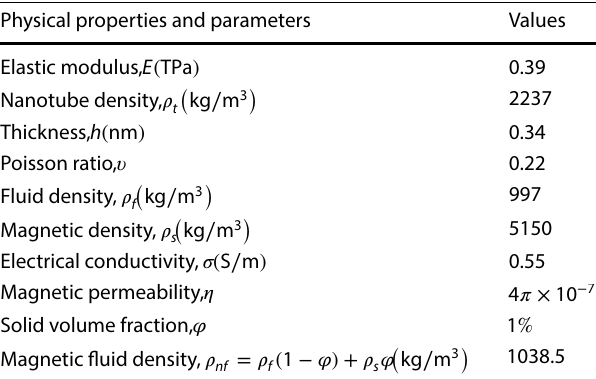
= 0.19 nm , ea = 0.3 nm and m